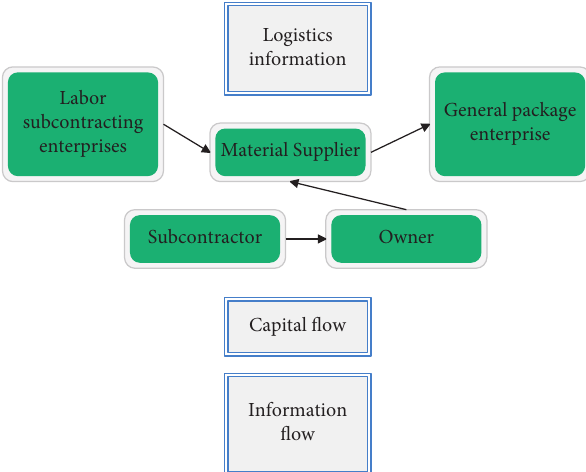
Figure 8: Construction of project management